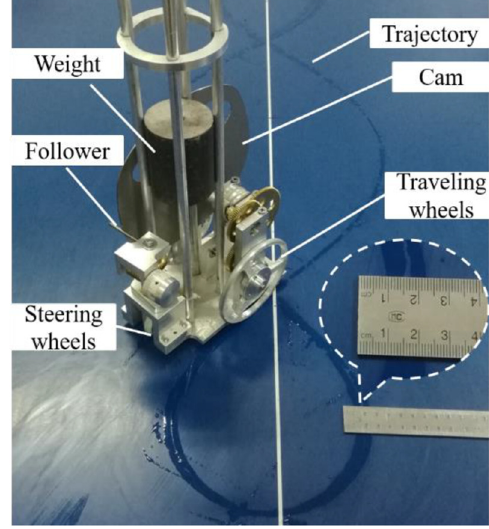
Fig. 7. “ Double 8 ” trajectory vehicle experiment.